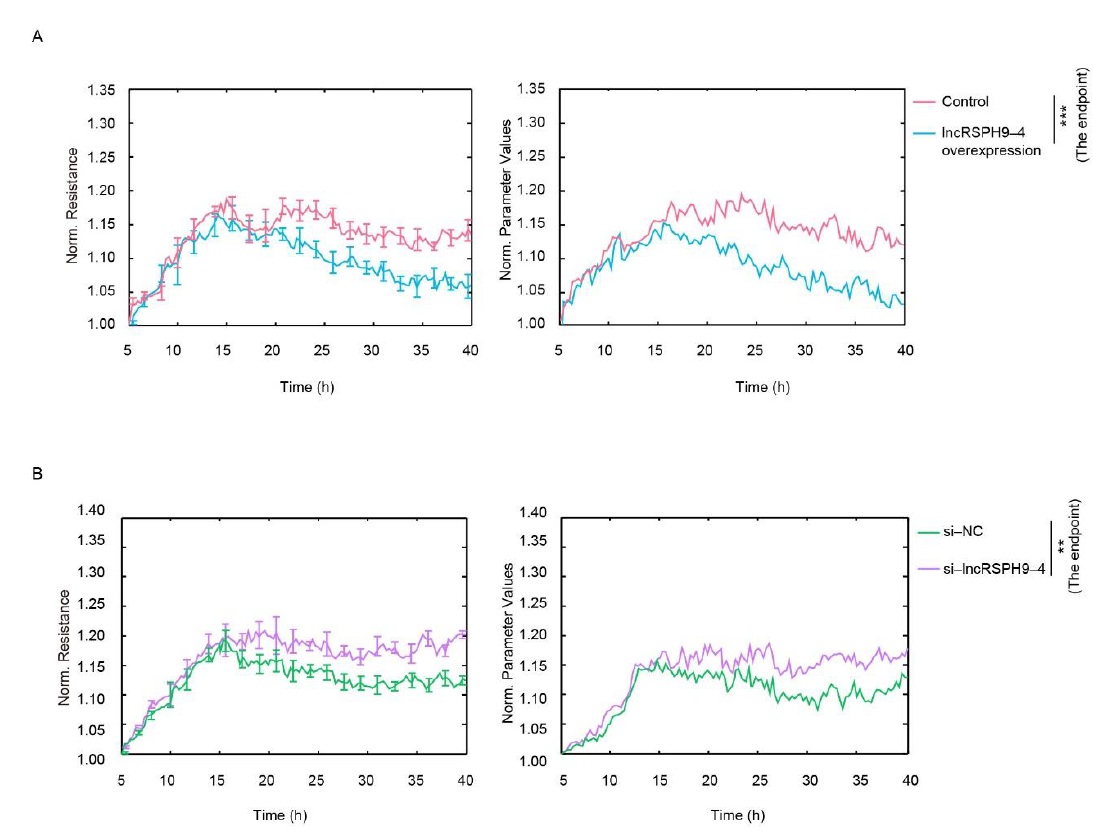
Figure 2. The impedance analyses of the hBMECs monolayer with lncRSPH9-4 overexpression or knocking-down. ( A ) The impedance changes of hBMECs by the overexpression of lncRSPH9-4 , monitored by the ECIS system. Data were collected and presented as mean ± SD from three replicated wells at each time point. *** p < 0.001. ( B ) The impedance changes of hBMECs with knocking-down of lncRSPH9-4 determined by ECIS. Data were collected and presented as mean ± SD from three replicates at each time point. ** p < 0.01.